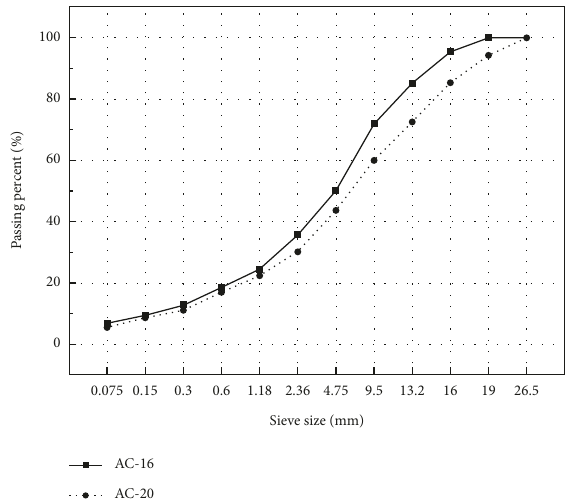
Figure 2: Aggregate gradation of AC-16 and AC-20 asphalt mixtures.